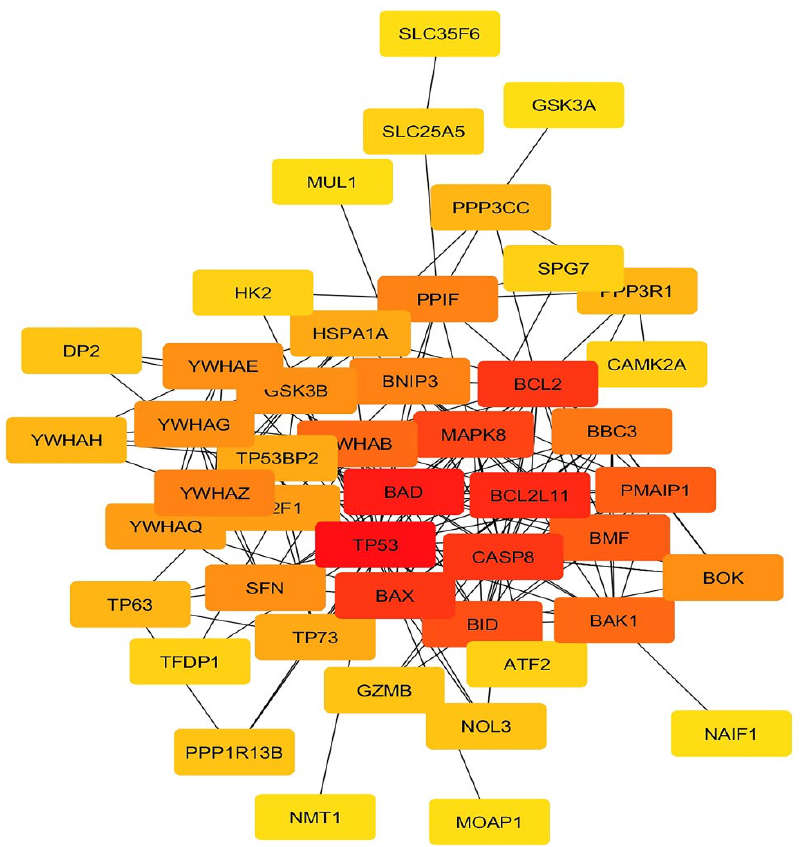
Figure 2. PPI (Protein–Protein Interaction) network and top hub genes. Hub genes were identified from all genes by using the degree analysis method. Genes’ ranking is based on the red spectrum. The higher gene rank is shown by red, while the color of lower ranking is yellow.